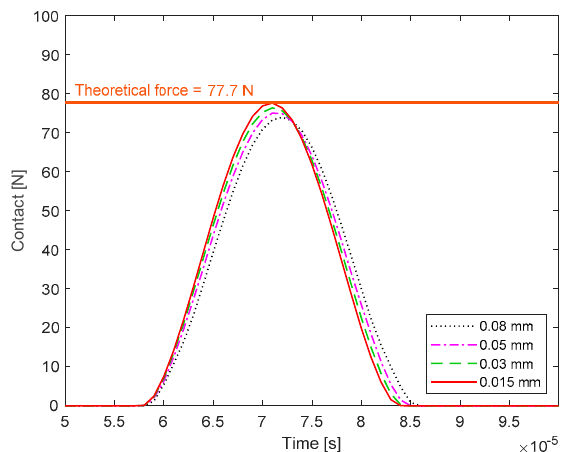
Figure 7. The initial position of the sphere in a dynamic simulation.